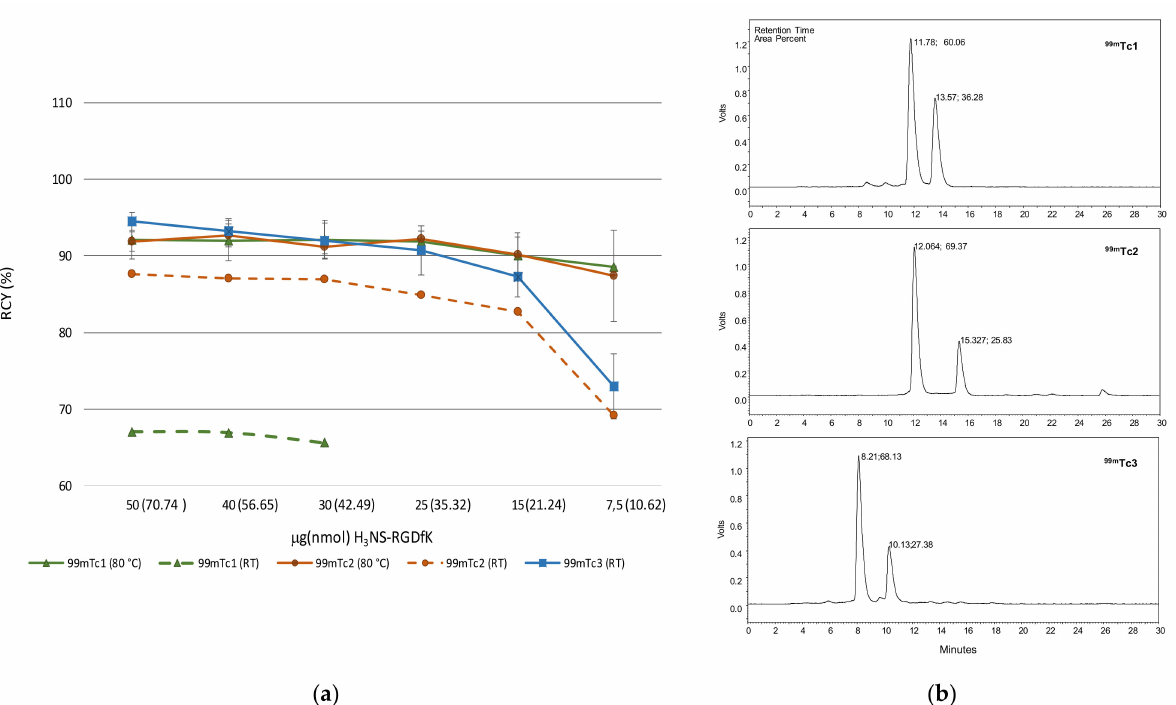
Figure 3. ( a ) Labeling efficiency; ( b ) chromatograms of the purified 99m Tc1–3 collected according to method 2 described in Table